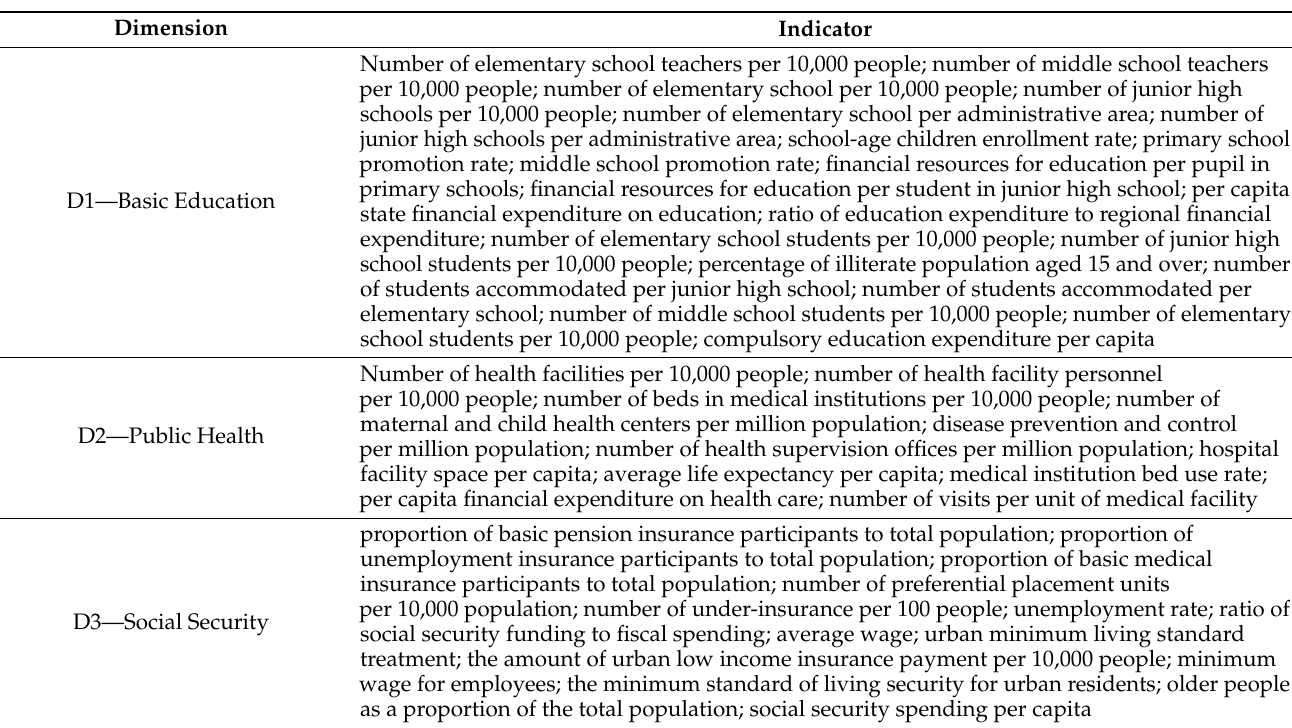
Table 3. Candidate indicators for evaluating the quantitative performance of